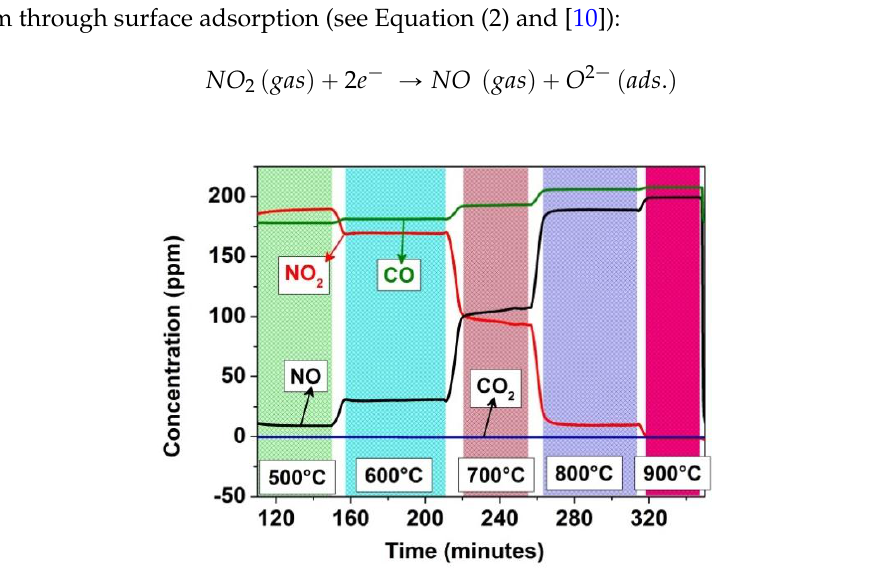
Figure 4. NO 2 response of Al-doped TiO 2 in dry argon environment at 600 °C and 800 °C